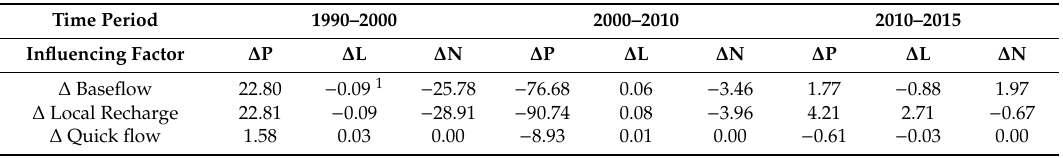
Table 4. The individual contributions of precipitation, land cover, and NDVI change on water yield changes. ∆ P is the contribution of precipitation change on water yield; ∆ L is the contribution of land cover change; ∆ N is the contribution of NDVI change (Unit: